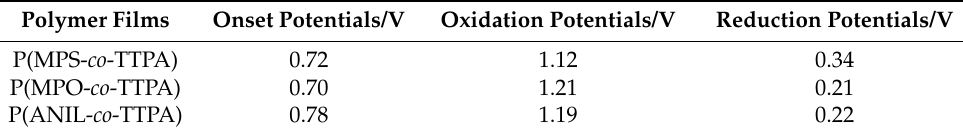
Table 1. The onset potentials, oxidation potentials, and reduction potentials values of copolymer films.